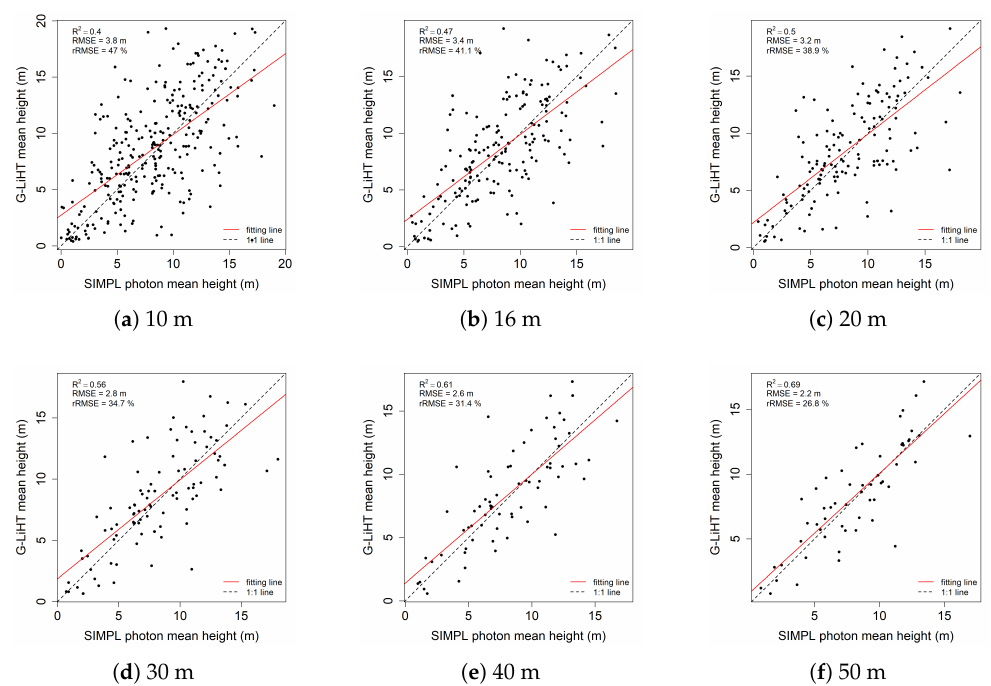
Figure 10. The relationship between the mean value of all photon heights from SIMPL and the mean value of all return heights from G-LiHT for different scales.